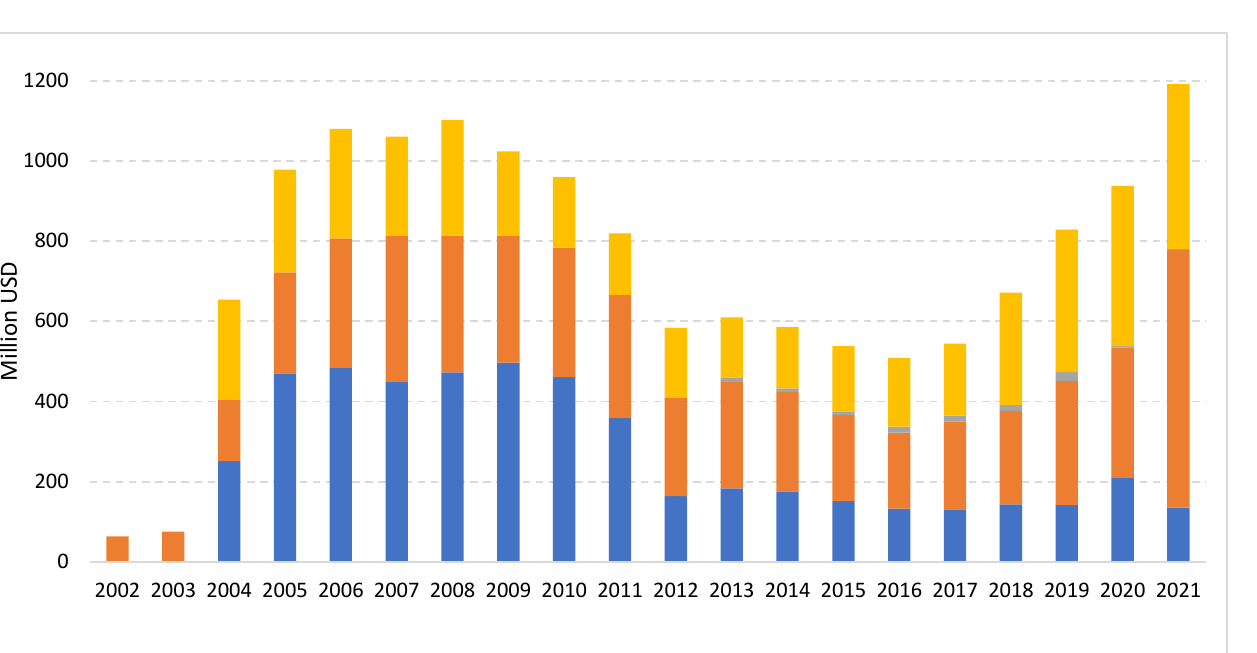
Figure 3. Public RD&D for hydrogen and fuel cells, spending in million USD (2021 prices and exchange rates), compiled by source [33].